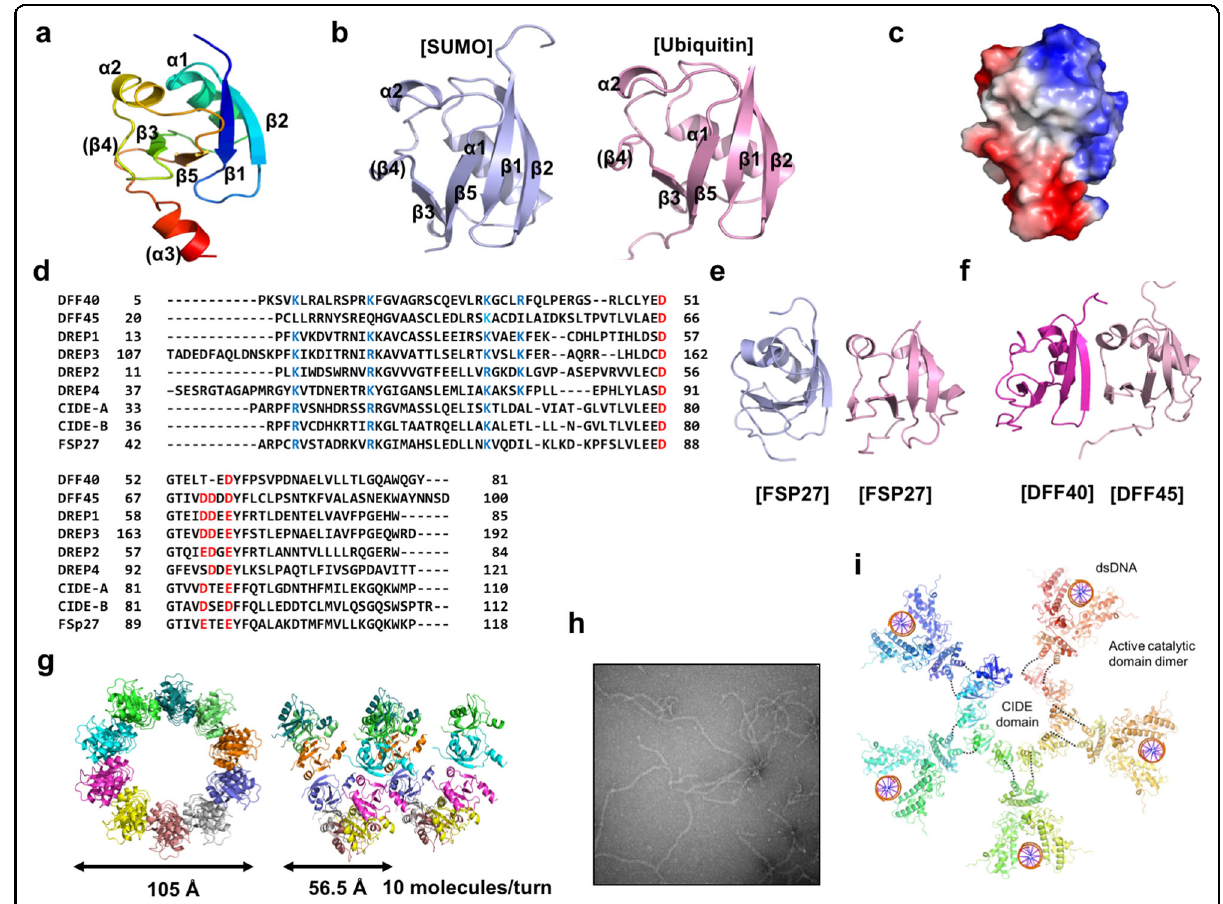
Fig. 4 Various forms of the CIDE domain and their functional implications. a Typical structure of the CIDE domain. A representative DREP4 CIDE domain is presented. Secondary structures are indicated on the corresponding structure. Rainbow colors indicate the N-terminus in blue and the C-terminus in red. b Structural homologs of the CIDE domain. c The common surface feature of the CIDE domain, which contains distinct acid and basic patches on opposite sides. The DREP4 CIDE domain generates an electrostatic surface charge distribution. d Sequence alignment between various CIDE domains. Conserved charged residues involved in the formation of acidic and basic patches are indicated in red and blue, respectively. e The prototype homodimeric structure of the CIDE domain. The homodimeric CIDE structure is presented based on the structure of the FSP27 CIDE domain. f The prototype heterodimeric structure of the CIDE domain. The DFF40 CIDE and DFF45 CIDE complexes are representative of the heterodimeric interactions of CIDE domains. g Helical fi lament assembly of the CIDE domain was revealed by a structural study of the DREP4 CIDE domain. The top and side views of the DREP4 CIDE helical fi lament structure are shown in the left and right panels, respectively. h CIDE helical fi lament formation in solution. Negative stained images by electron microscopy show DREP4 CIDE fi lament formation in the solution. i Proposed model of DFF40 fi lament assembly during apoptotic DNA